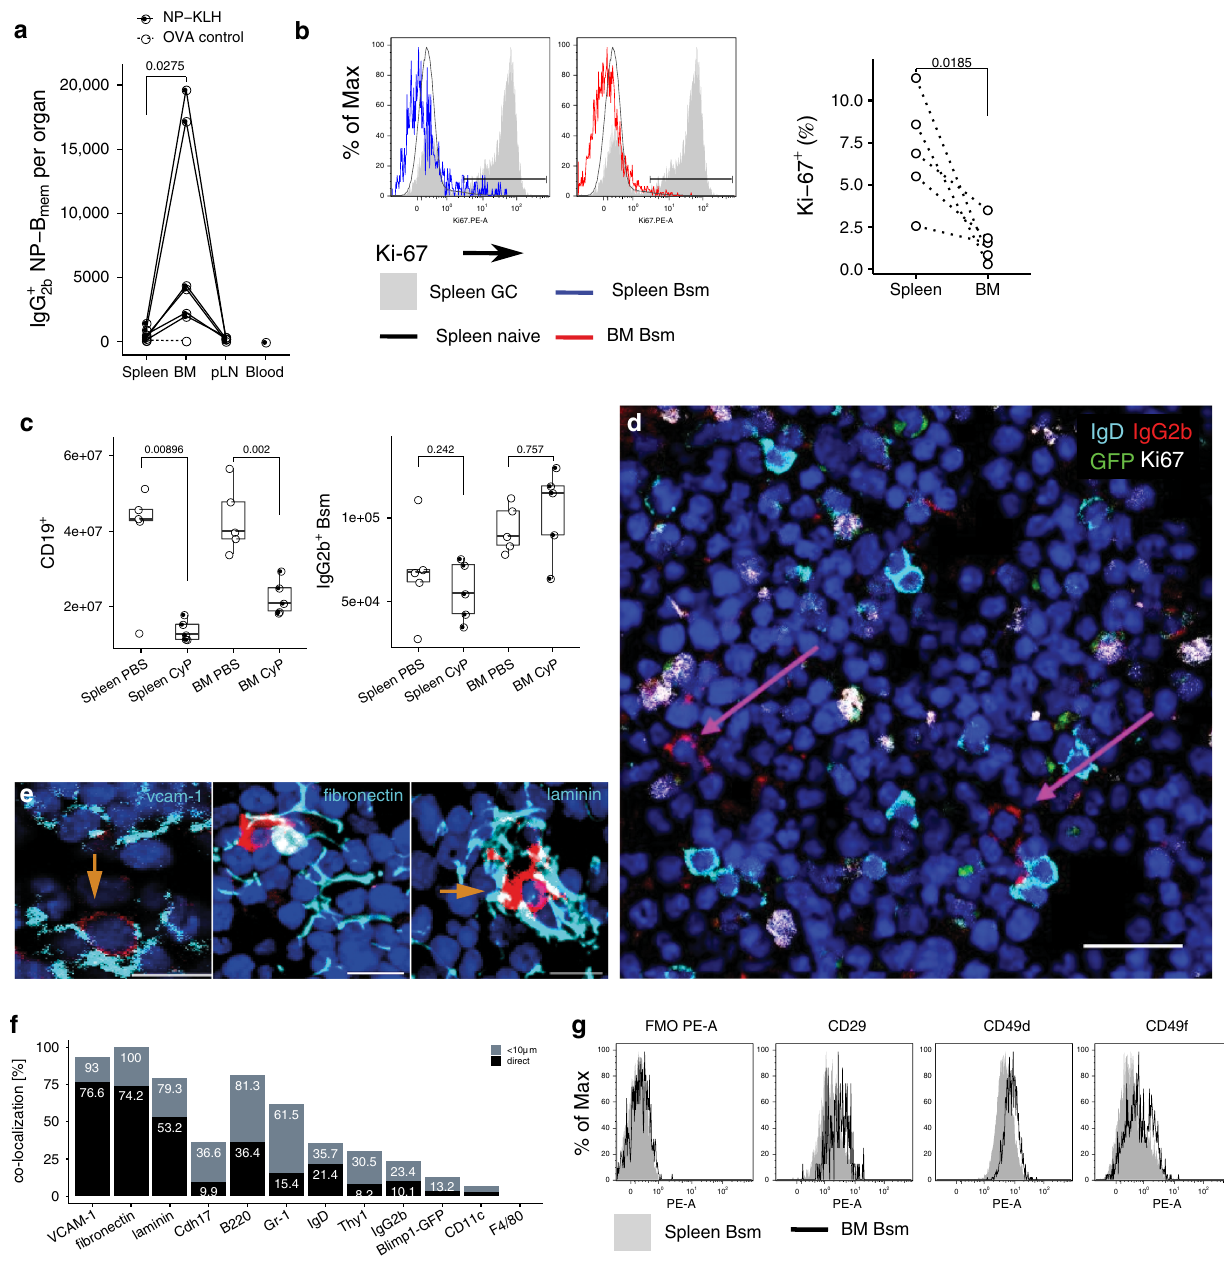
(Fig. 4). By fl ow cytometry, and using only CD21/35 and CD23 on gated Bsm, we were able to identify populations of CD21/ 35 intermediate /CD23 intermediate (cluster I), CD21/35 intermediate CD23 high (cluster II), and CD21/35 high CD23 low (cluster IV)